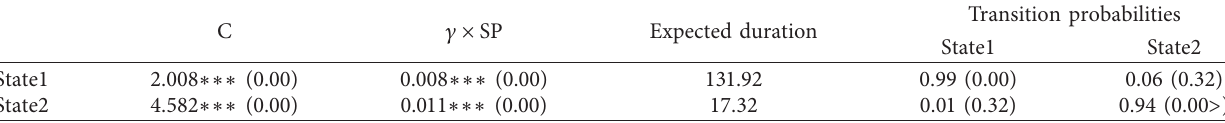
Table 1: Estimated coefficients for the Markov-switching model.